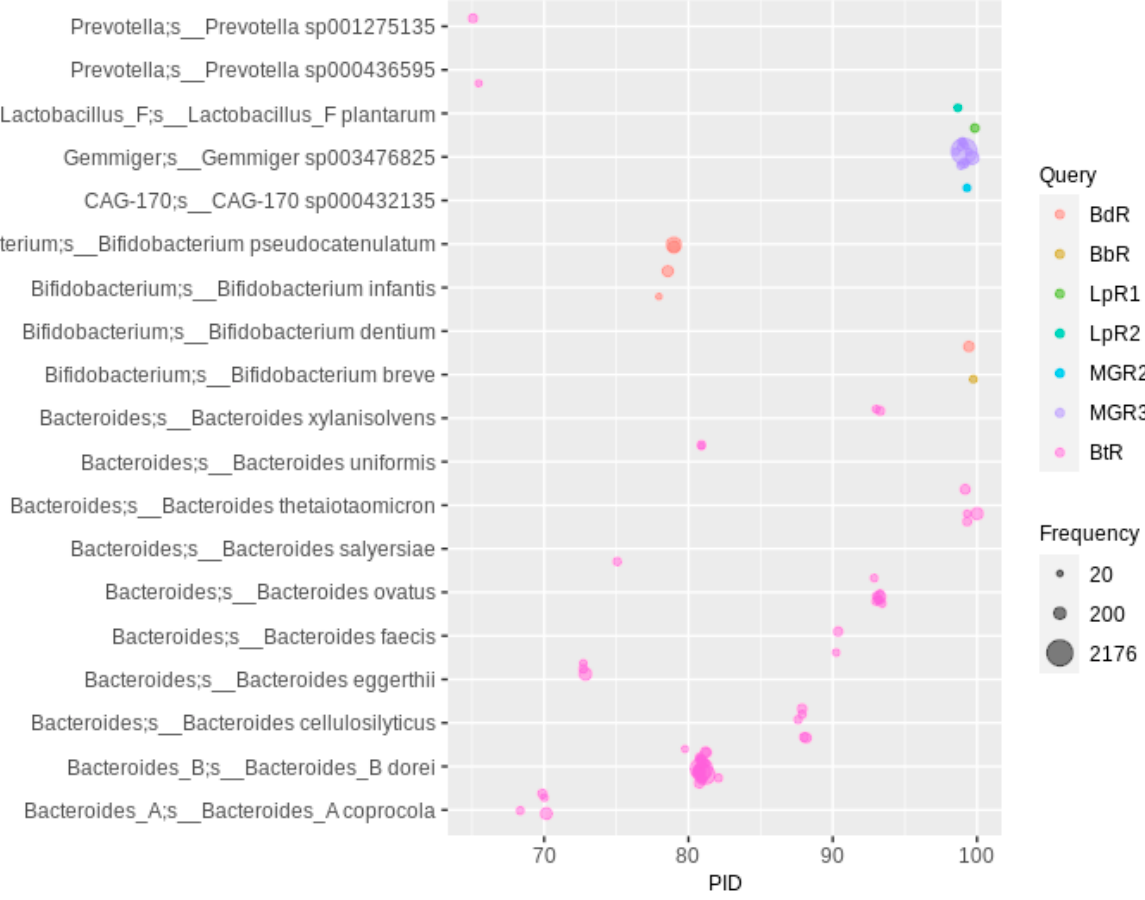
Figure 2. Rhamnosidase homologs in human gut MAGs. A PID threshold of 65 was chosen for the queries shown in the color code (for abbreviations and details, see Table 1; hits with a lower PID are shown in Supplementary Figure S4). Hits were filtered for at least 20 occurrences, so that each bubble represents a number of redundant sequences ranging from 20 to 2176.